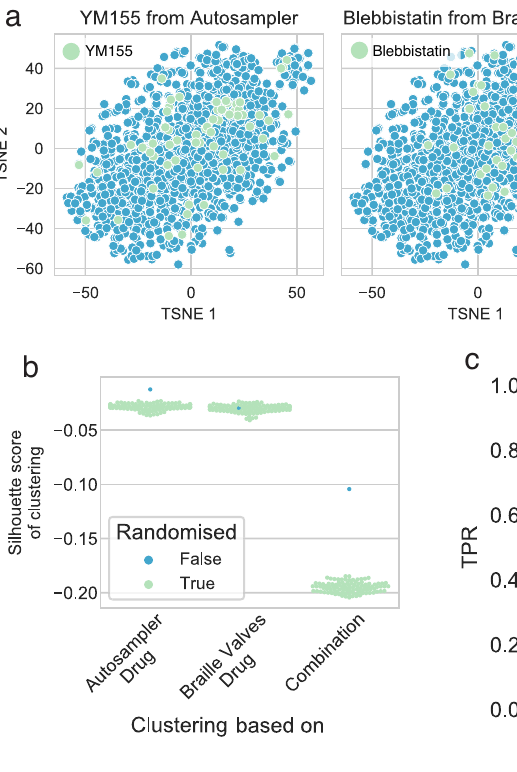
analysis of drug signature similarity to LINCS-L1000 data. For each drug, a con- sensus signature was calculated and similarity (Spearman ’ s rank correlation) to corresponding LINCS-L1000 signatures was calculated. The similarity values were used as predicted values for ROC analysis, while true positives were the matched drug pairs between the high-throughput screen and LINCS-L1000.Source data are provided as a Source Data fi